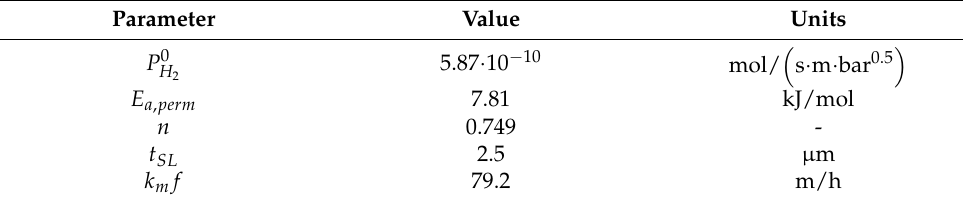
Table 2. Double-skin membranes parameters for permeation equation.